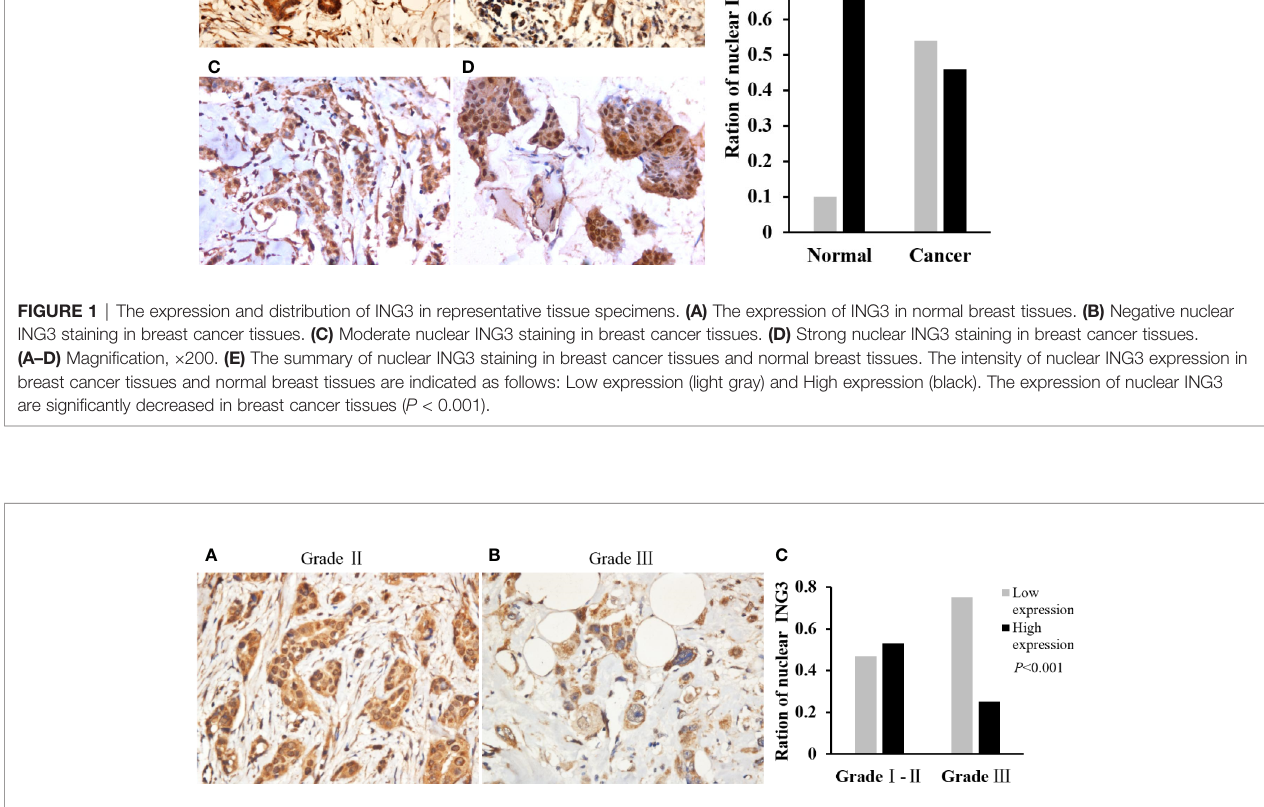
FIGURE 2 | Analyses of nuclear ING3 expression in breast cancer with low-grade and high-grade. (A, B) The representative of nuclear ING3 staining in low-grade and high-grade breast cancer. (A, B) Magni fi cation, ×400. (C) The c 2 test and Spearman ’ s rank result of nuclear ING3 staining in breast cancer with low-grade and high-grade ( P <